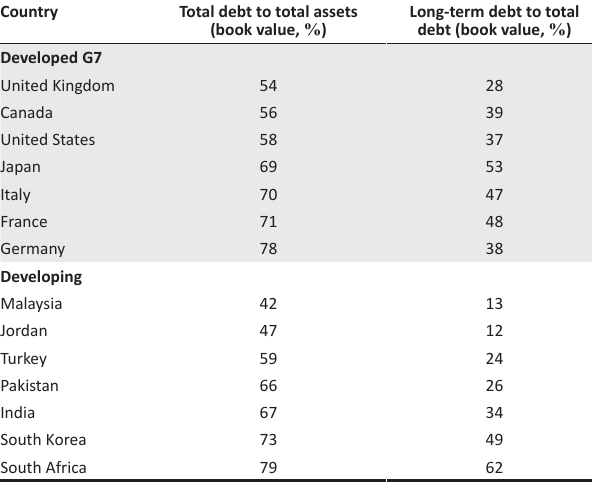
TABLE 2: Capital structures in different countries. Country Total debt to total assets Long-term debt to total (book value, % ) debt (book value, % ) Developed